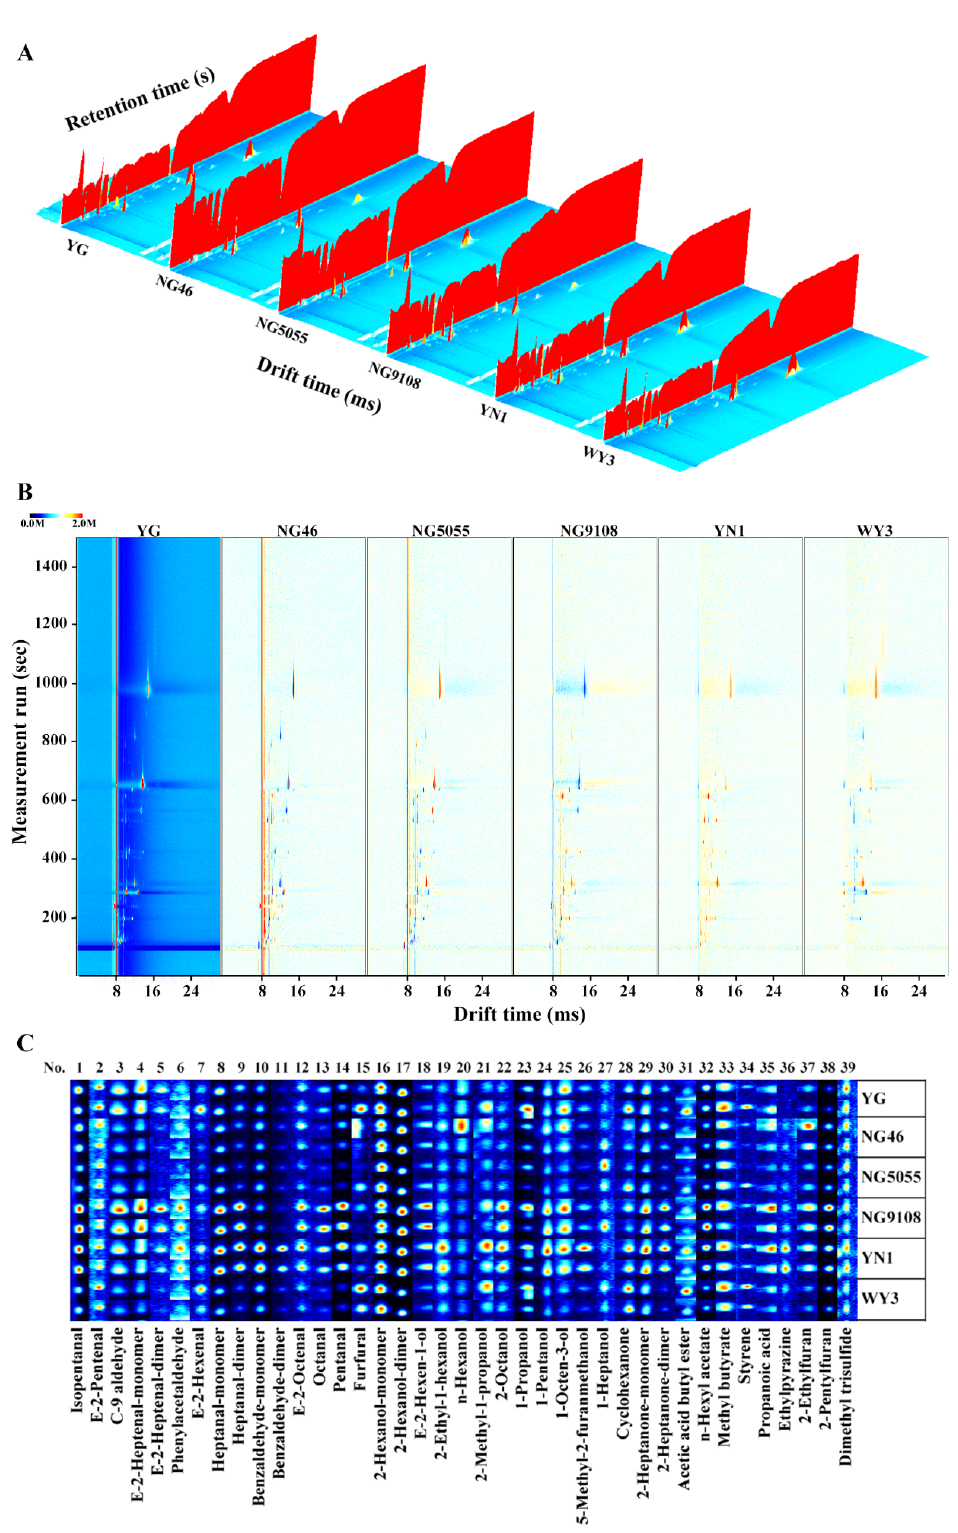
Figure 1. The 3D topographic map of volatile organic flavor compounds ( A ), difference comparison map of volatile organic flavor compounds ( B ), and the fingerprints of volatile organic flavor compounds ( C ) in 6 different cooked rice.